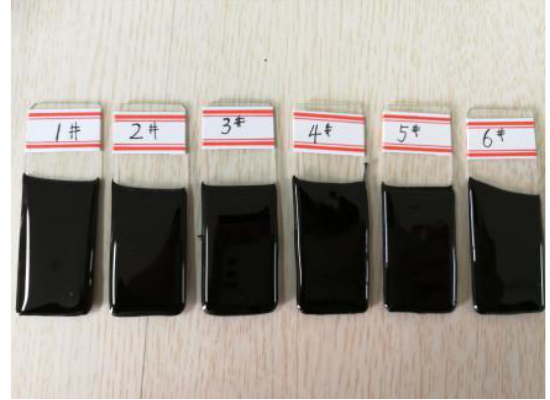
Figure 4. Asphalt specimen.